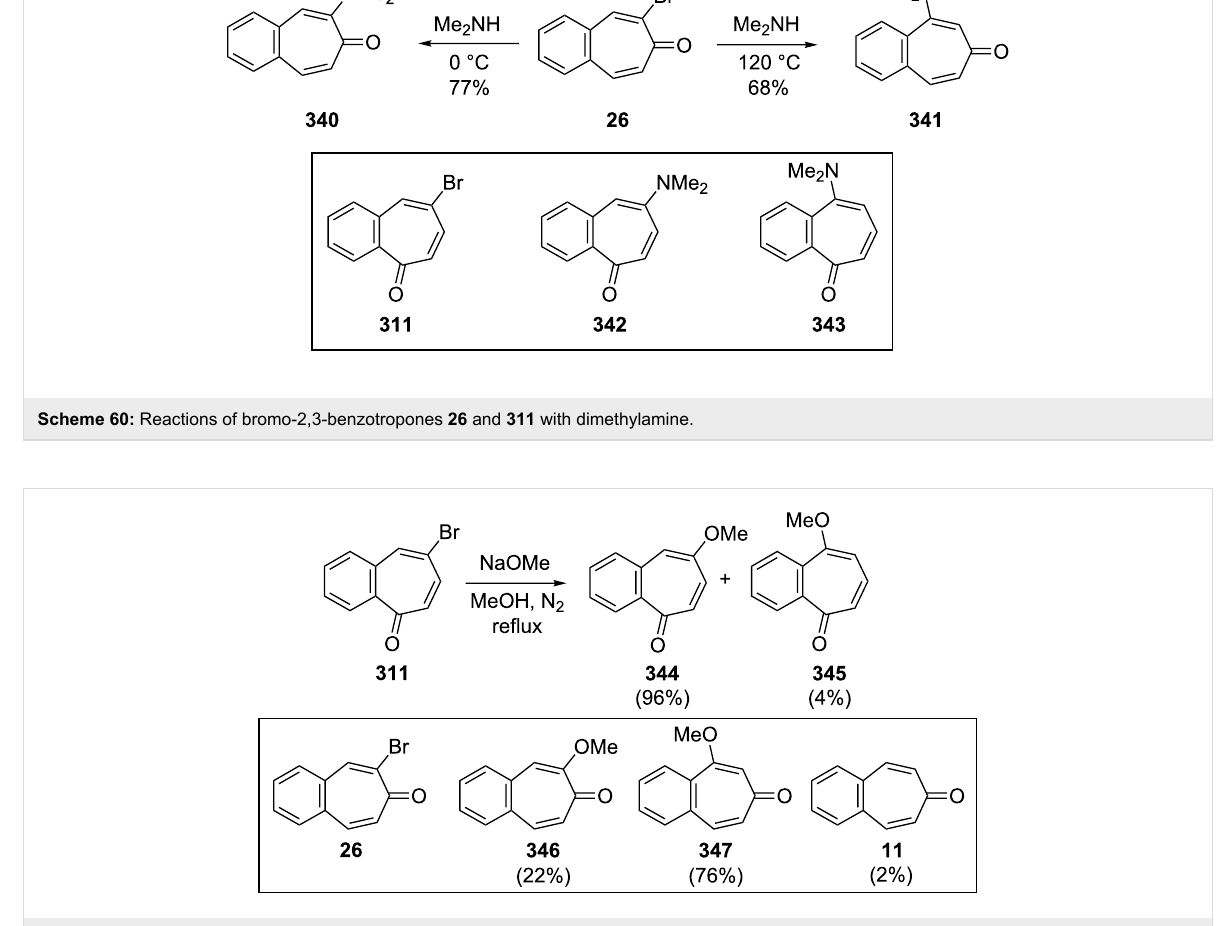
Scheme 61: Reactions of bromobenzotropones 311 and 26 with